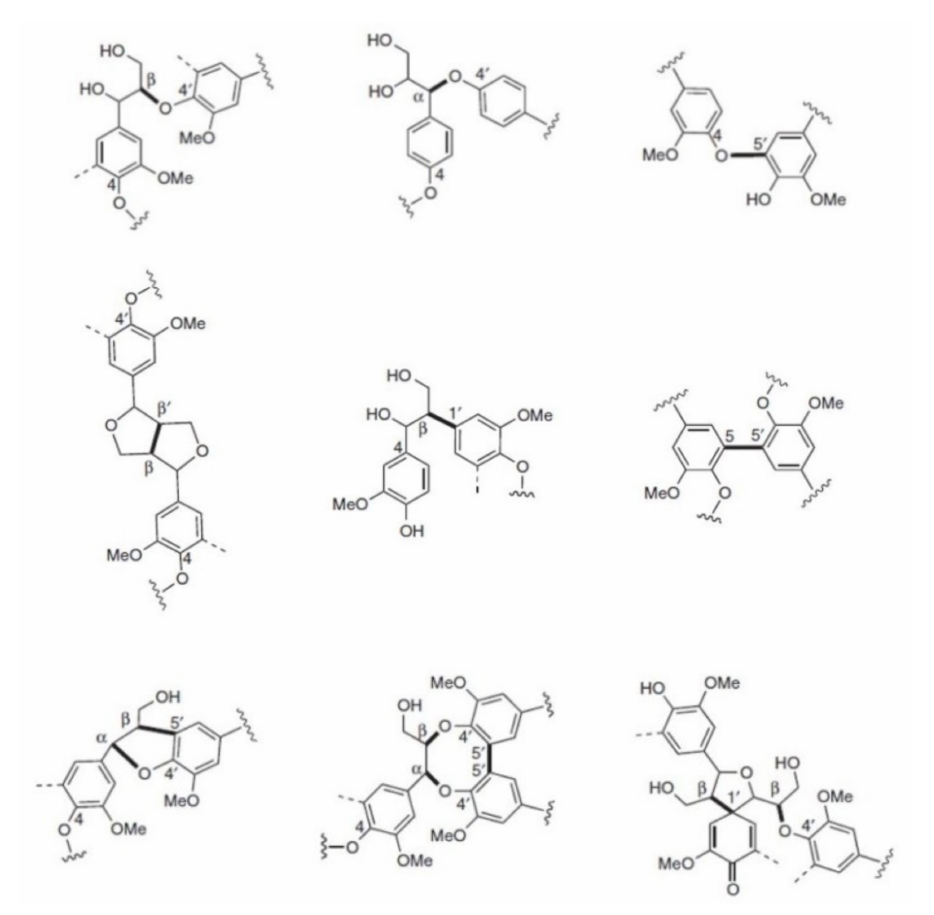
Figure 1. Monolignol linkages. First line: Ether bonds (ß-O-4’, α -O-4’, 4-O-5’). Second line: C-C-bonds. (ß-ß’, ß-1’, 5-5’) and third line: more complex linkages (ß-5’/ α -O-4’, 5-5’/ ß-O-4’/ α -O-4’, ß-1’/